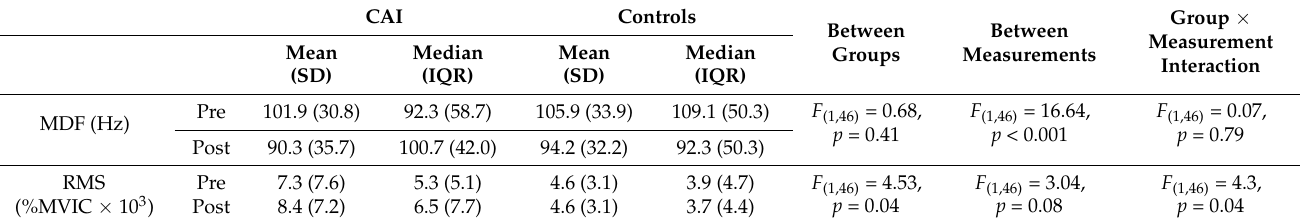
Table 2. Secondary analysis of EMG signal at 200 ms after heel